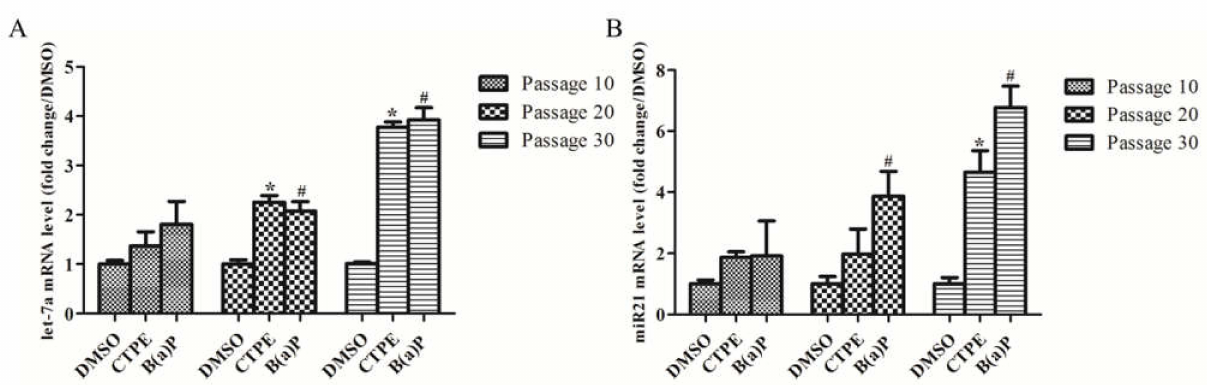
Figure 4. The protein levels of DNMT1, DNMT3a, DNMT3b, and HDAC1 in the culture supernatants. The protein levels of ( A ) DNMT1, ( B ) DNMT3a, ( C ) DNMT3b or ( D ) HDAC1 in cell supernatants of DMSO, CTPE, and B(a)P groups at passage 10, 20 and 30. The results were presented as mean ± SD ( n = 3, *: CTPE vs. DMSO, p < 0.05. #: B(a)P vs. DMSO, p < 0.05).